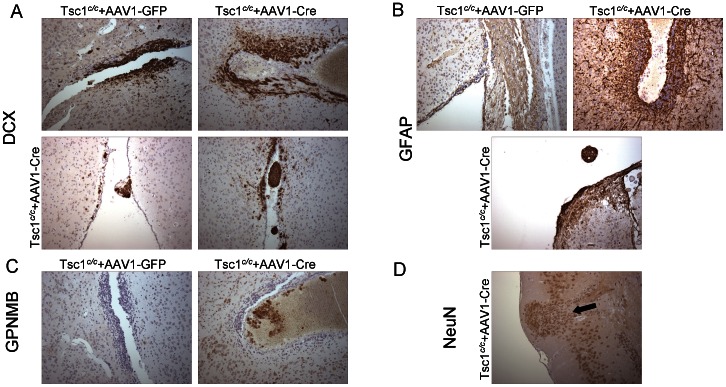
DCX, GFAP, GPNMB and NeuN staining in brains of AAV1-CBA-Cre and AAV1-CBA-GFP P0 injected Tsc1c/c mice at 1 month.
Tsc1c/cROSA homozygous pups were injected ICV at P0 with either an AAV1-CBA-GFP or AAV1-CBA-Cre vector at a concentration of 2×1010g.c. One month later pups injected with AAV1-CBA-Cre virus were sacrificed and processed for immunohistochemistry and showed severe hydrocephalus (N = 2). The pups (A) Staining for DCX revealed positive regions along the ventricles(anterior to the striatum, at the level of septal nuclei) in control animals (Fig. 12A, top left panel), but those regions were enlarged in AAV1-CBA-Cre injected animals (Fig. 12A, top right). In addition, the latter animals showed small DCX positive nodules [Fig. 12A, bottom left (level close to anterior amygdale) and right (level of septal nuclei)], which were not seen in control animals. (B) No strong GFAP staining were seen in the ventricular lining (level of septal nuclei) of control brains, but was intense in some subventricular regions (anterior to striatum) of the AAV1-CBA-Cre injected animals (Fig. 12B, top panels), including some GFAP positive nodules in the CSF space at the level of septal nuclei (Fig. 12B, bottom panel). (C) GPNMB staining was virtually null in control brains, with some positive cells near the ventricles anterior to striatum in AAV1-CBA-Cre injected animals (Fig. 12C). (D) NeuN staining of brains revealed rare heterotopias (arrow) consisting of outgrowth of glial cells into the cerebral cortex. Magnification = 20X.